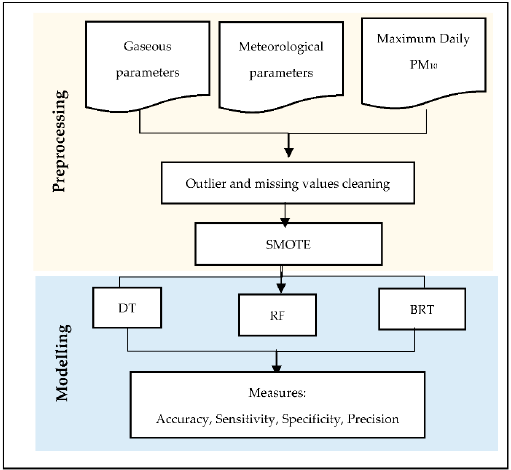
Figure 2. Flowchart of steps in this